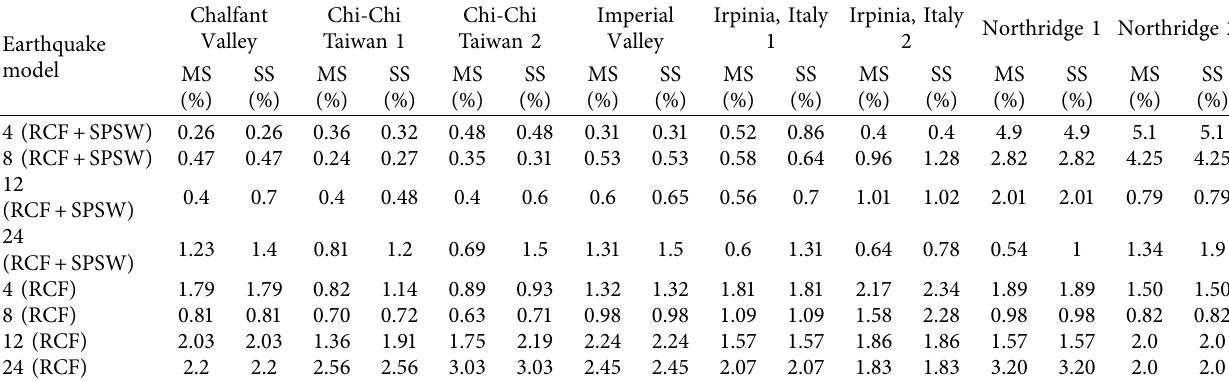
Table 18: Results of peak interstory drift demand of models in the MS and SS for earthquakes Group II. Earthquake